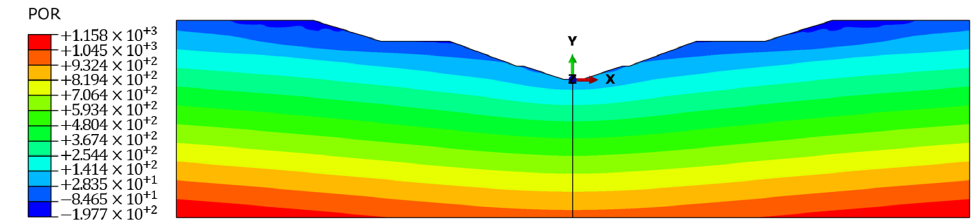
Figure 10. Canal pore pressure contour when t = 10 years.